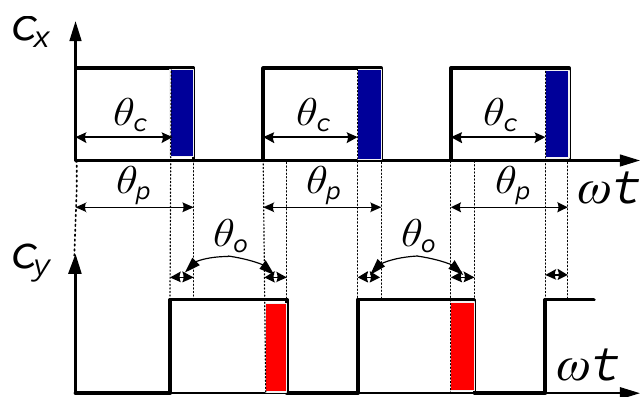
Figure 4. Inductor current elimination through turn-off delay angle.